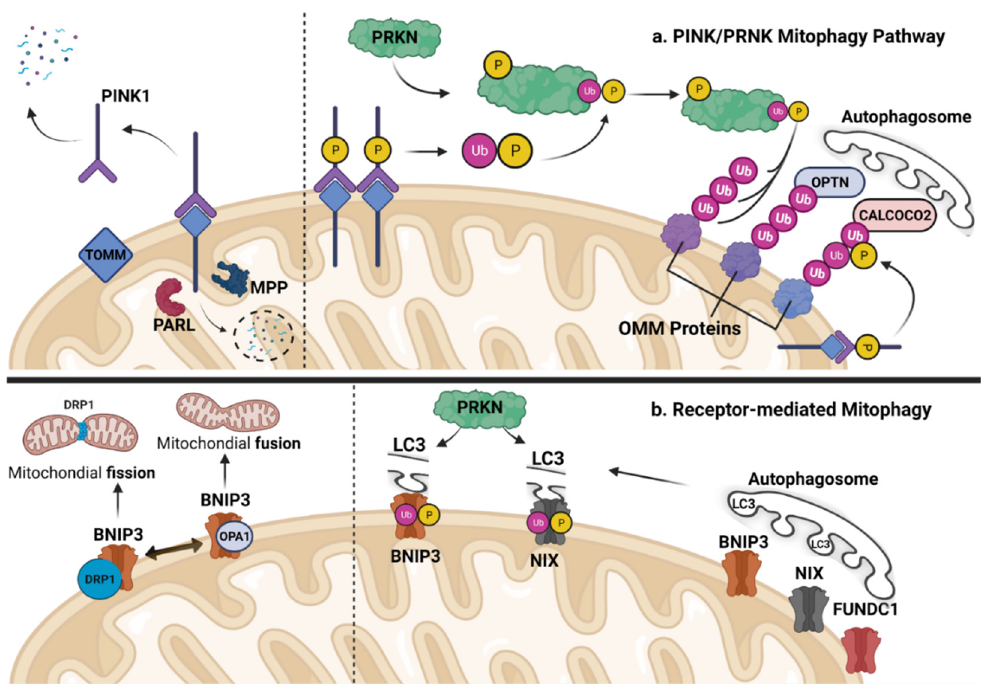
Figure 3. ( a ) The PINK1/PRKN mitophagy pathway. Under normal conditions, PTEN-induced ki- nase 1 (PINK1) partially enters mitochondrion, where it is severed by presenilin-associated rhom- boid-like protein (PARL) and mitochondrial processing peptidases (MPPs), and then released into the cytosol to be degraded (left side of dashed line). However, when the inner mitochondrial mem- brane potential collapses (right side of dashed line), PINK1 can build up on the outer mitochondrial membrane, triggering parkin RBR E3 Ubiquitin Protein Ligase (PRKN) phosphorylation both di- rectly and indirectly through ubiquitination. The highly activated PRKN can then mark outer mito- chondrial membrane (OMM) proteins with ubiquitin, making them recognizable to cargo proteins such as optineurin (OPTN) and coiled-coil domain 2 (CALCOCO2), which leads to their degrada- tion through the process of autophagy. ( b ) Receptor-mediated mitophagy. Specific receptors target damaged mitochondria for removal. BCL2 interacting protein 3 (BNIP3), NIX (BCL2 Interacting Protein 3-Like), and FUN14 domain containing 1 (FUNDC1) are examples of these receptors that are located on the outer mitochondrial membrane and interact directly with microtubule-associated protein light chain 3 (LC3), a protein involved in autophagy, to eliminate damaged mitochondria. The interaction between NIX and BNIP3 with LC3 is enhanced by their phosphorylation. While FUNDC1 does not interact with PINK1/PRKN to cause mitophagy, the ubiquitination of NIX and BNIP3 receptors by PRKN highlights the complex relationship between receptor-mediated mitoph- agy and the PINK1/PRKN mitophagy pathway. These receptors promote the division of damaged organelles by breaking down and releasing optic atrophy gene 1 (OPA1) and by attracting to the mitochondrial surface the dynamin-related protein 1 (DRP1), a protein that mediates mitochondrial fission through the scission of the outer mitochondrial membrane (left side of dashed line). OPA1 can activate DRP1, which then induces the division of mitochondria. This division is essential for the removal of damaged mitochondria and the maintenance of mitochondrial quality control. On the other hand, OPA1 is also involved in the fusion of the inner mitochondrial membrane and is required for the maintenance of the normal cristae structure and respiratory function of mitochon- dria. The fusion of mitochondria by OPA1 is inhibited by the actions of DRP1, ensuring that the division and merging processes are properly balanced.